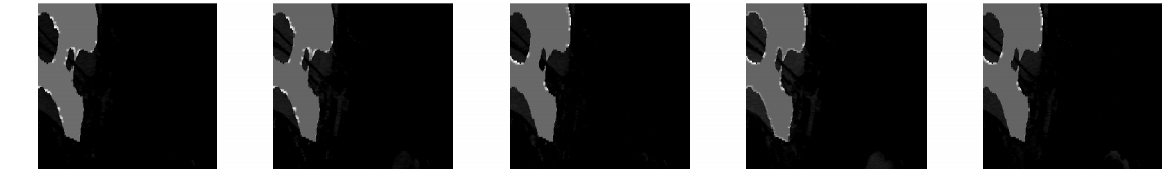
Figure 9. Examples of DSMT change detection maps selected through the SAR images time series .